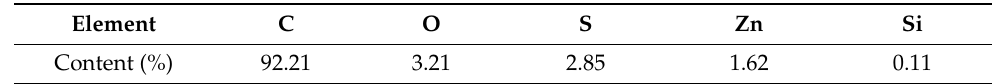
Table 2. Performance indexes of high-performance water reducer. Table 3. Element type and relative content.